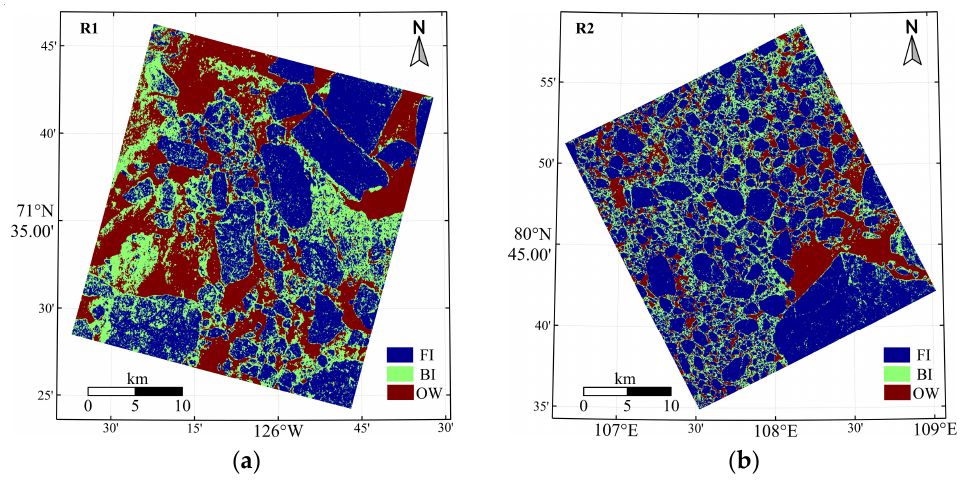
Figure 9. Sea ice classification results obtained using ( a ) R1-1 and ( b ) R2-6 scene data based on MSI-ResNet, with the VV, VH, and HH polarization data in a patch size of 31 × 31. Table 4. Sea ice classification confusion matrices for the R1-1 and R2-6 scene data based on MSI-ResNet, and the R3-15 scene data based on the LibSVM classifier.